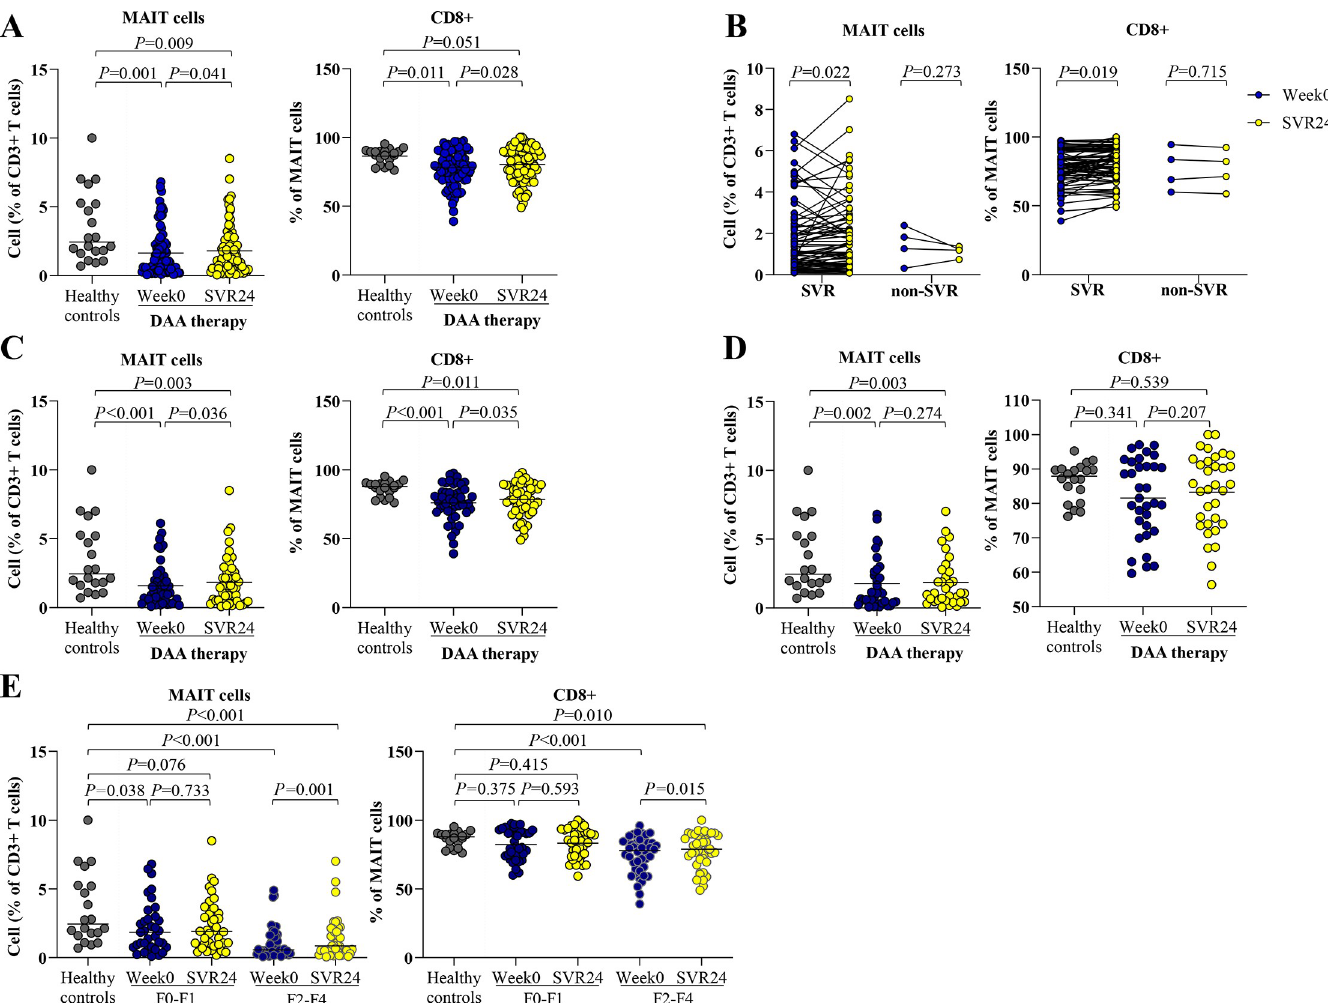
Fig 3. Circulating MAIT and CD8+ MAIT cells in blood of HCV-infected patients at pre- and post-treatment. (A) Percentage of MAIT cells and CD8+ MAIT cells at pre-treatment (week0) and post-treatment (SVR24) in all HCV-infected patients compared to healthy controls. (B) Percentage of MAIT cells and CD8+ MAIT cells in patients achieving sustained virological response (SVR) and non-SVR. (C) Percentage of MAIT cells and CD8+ MAIT cells in HCV-monoinfected patients achieving SVR. (D) Percentage of MAIT cells and CD8+ MAIT cells in HCV/HIV-coinfected patients achieving SVR. (E) Percentage of MAIT cells and CD8+ MAIT cells according to liver fibrosis stages. Data presented as median and IQR. Statistical comparison was tested was tested using Mann-Whitney test for comparing two independent samples or Wilcoxon signed-rank test for comparing paired data samples (A-E).